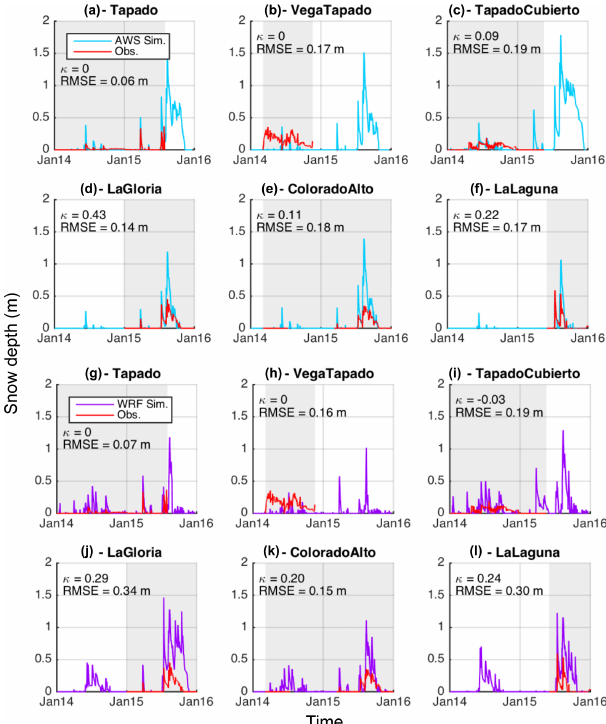
Figure 5. Simulated (cyan and purple) vs. observed (red) snow depth at six automatic weather stations. Cyan lines (a–f) represent simulations performed using AWS meteorological forcing. Purple lines (g–m) correspond to simulations performed using WRF mete- orological forcing. Grey shaded areas indicate the period of avail- able